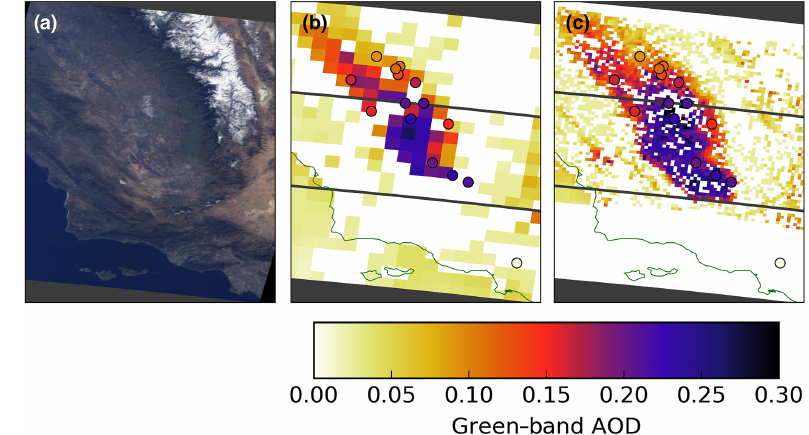
Figure 1. (a) The MISR true-color (RGB) image of the San Joaquin Valley in California on 20 January 2013 at around 18:50UTC; (b) MISR V22 17.6km aerosol optical depth (AOD); (c) MISR 4.4km AOD retrieved using the V22 aerosol retrieval algorithm with 275m local mode data as